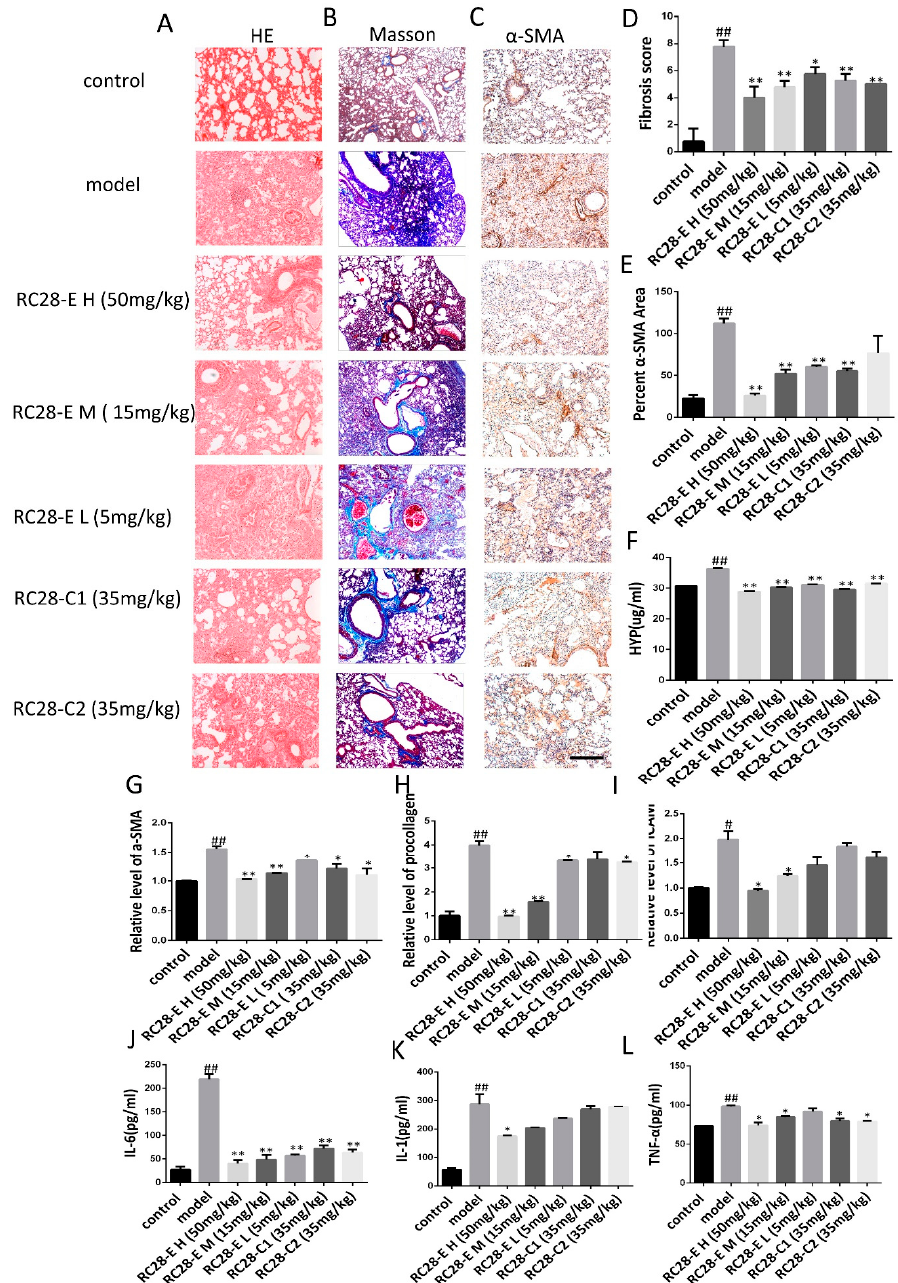
Figure 5. The e ff ect of RC28-E on the development of fibrosis in a therapeutic mouse bleomycin model. ( A ) The lung sections from the mice that have undergone di ff erent treatments were stained by Figure 5. The effect of RC28-E on the development of fibrosis in a therapeutic mouse bleomycin hematoxylin–eosin (HE). ( B ) Lung sections from various treatment groups were subjected to Masson model. ( A ) The lung sections from the mice that have undergone different treatments were stained by trichrome staining. ( C ) Immunohistochemistry was used to examine α -SMA expression in pulmonary tissues. Scale bar = 200 µ m for each picture (original magnification: × 100, n = 4 per group). ( D ) The lung fibrosis score based on the scoring from Ashcroft score. ( E ) Quantitative analysis of α -SMA positive area. ( F ) The e ff ect of RC28-E on hydroxyproline concentration in lung tissue. ( G – I ) The expression of α -SMA, procollagen, and ICAM mRNA were detected by qRT-PCR. ( J – L ) IL-1, IL-6, and TNF- α ELISA kit were used to detect the IL-1, IL-6, and TNF- α expression in the bleomycin induced lung tissue. Results are shown as mean ± SD. * p < 0.05, ** p < 0.01 versus model alone. # p < 0.05, ## p < 0.01 versus